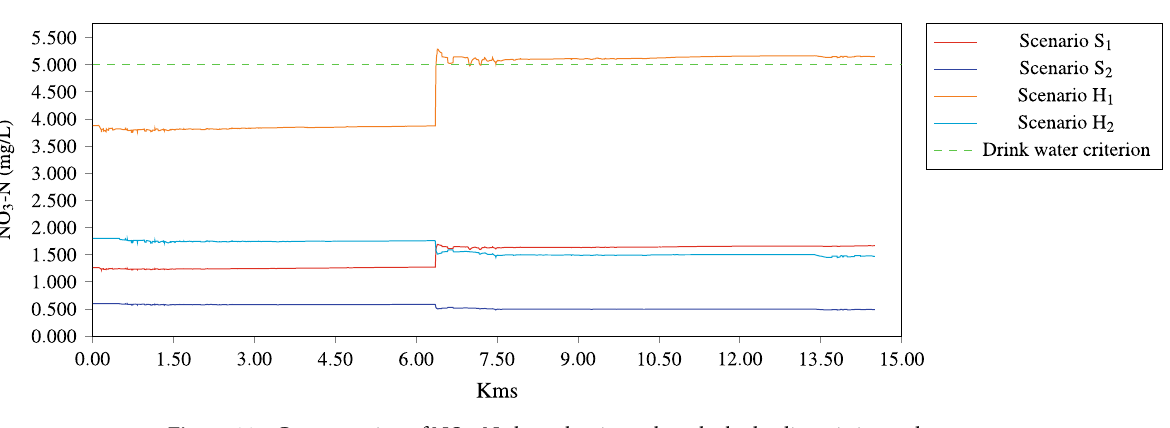
Figure 11. Concentration of NO 3 -N along the river when the hydrodinamic is